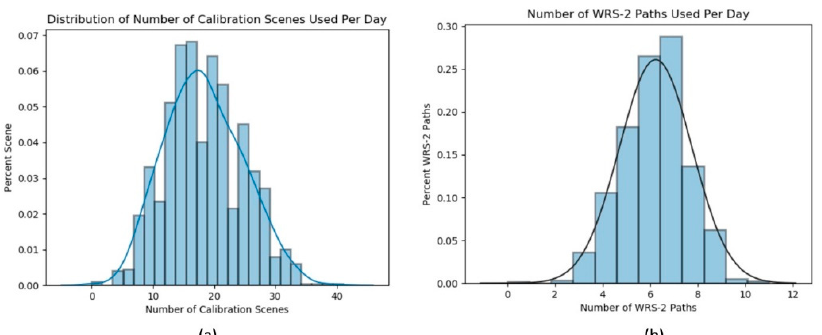
Figure 9. ( a ) The number of geometric calibration scenes used per day. ( b ) The number of WRS-2 paths for which geometric calibration scenes are used per day. Both figures demonstrate that the scenes used in the SSM geometric calibration process are well distributed throughout the day.